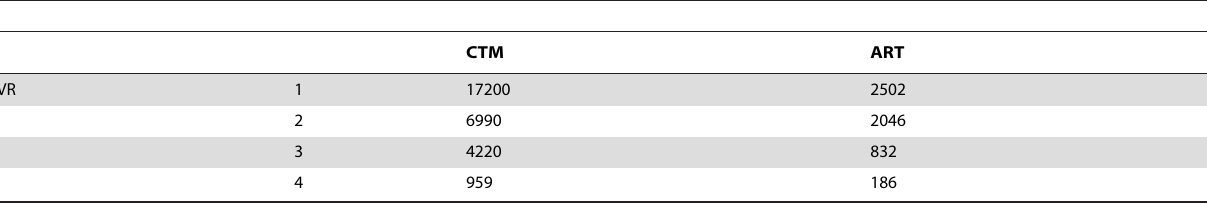
Table 3. HCV RNA levels according to ART and CTM in samples obtained 12 weeks after TVR treatment that yielded levels $ 50 IU/ ml in at least one of the two assays.